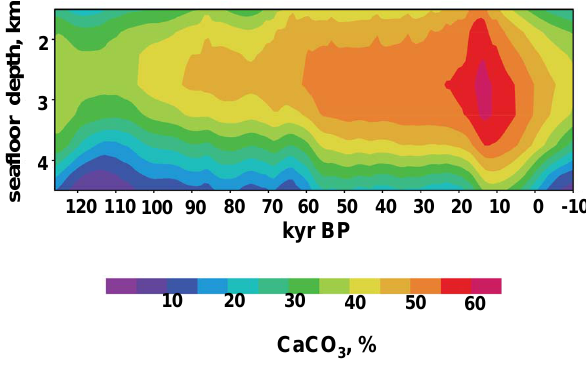
Fig. 4. Dynamics of the vertical distribution of the simulated CaCO 3 fraction (%) in top layer of seafloor sediments averaged over 30 ◦ S–30 ◦ N in the Pacific